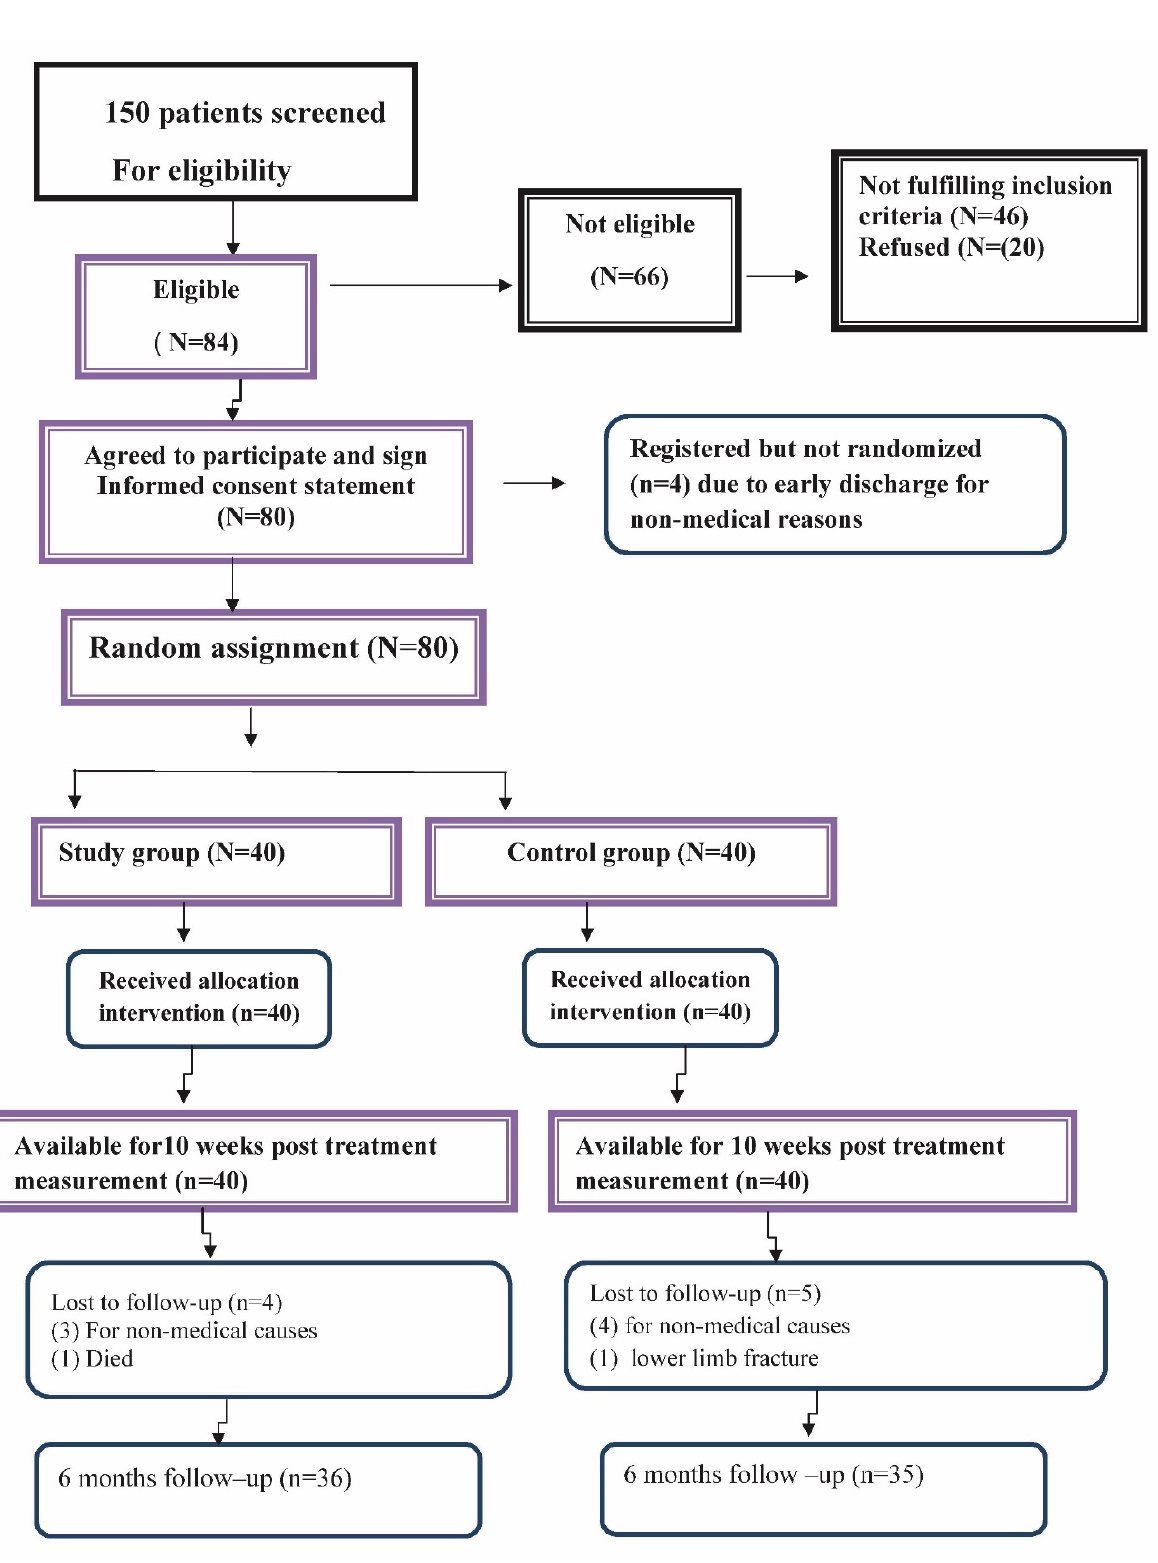
Figure 1. Flow of study participants. Interventions The patients in both groups received hot packs (15 min) and TENS therapy to control pain and eliminate the causal role of muscle spasms and/or tightness in changing